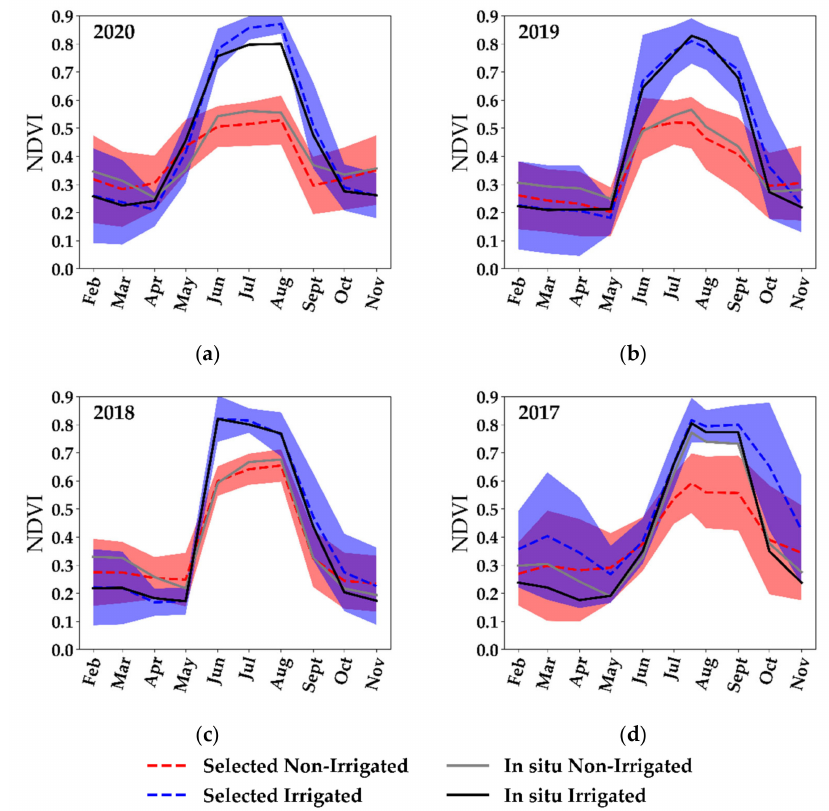
Figure 8. Comparison of average NDVI temporal profiles between selected training plots and in situ plots for ( a ) 2020, ( b ) 2019, ( c ) 2018, and ( d ) 2017. The red dashed line represents the selected non-irrigated plots while the grey line represents the in situ non-irrigated plots. The blue dashed line represents the selected irrigated plots while the black line represents the in situ irrigated plots. Shaded regions represent the standard deviation of the average NDVI for selected samples for both irrigated (blue) and non-irrigated (red). Number of in situ plots refers to Table 1 whereas the number of selected plots refers to Table 2 for the irrigated and non-irrigated classes each